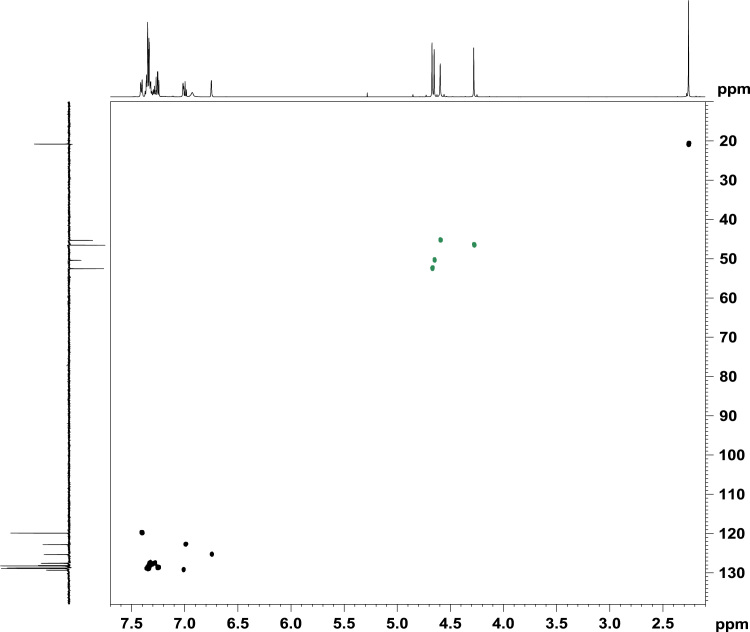
1H-13C HSQC spectrum of ligand S2.